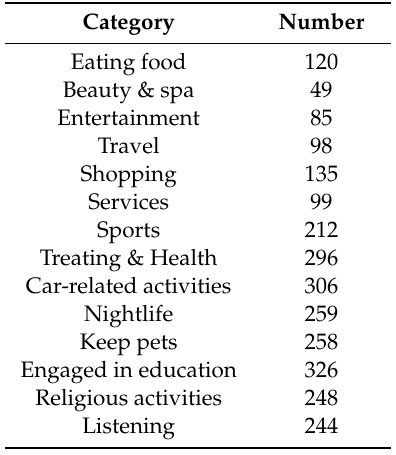
Table 4. Keywords and the number of categories in the